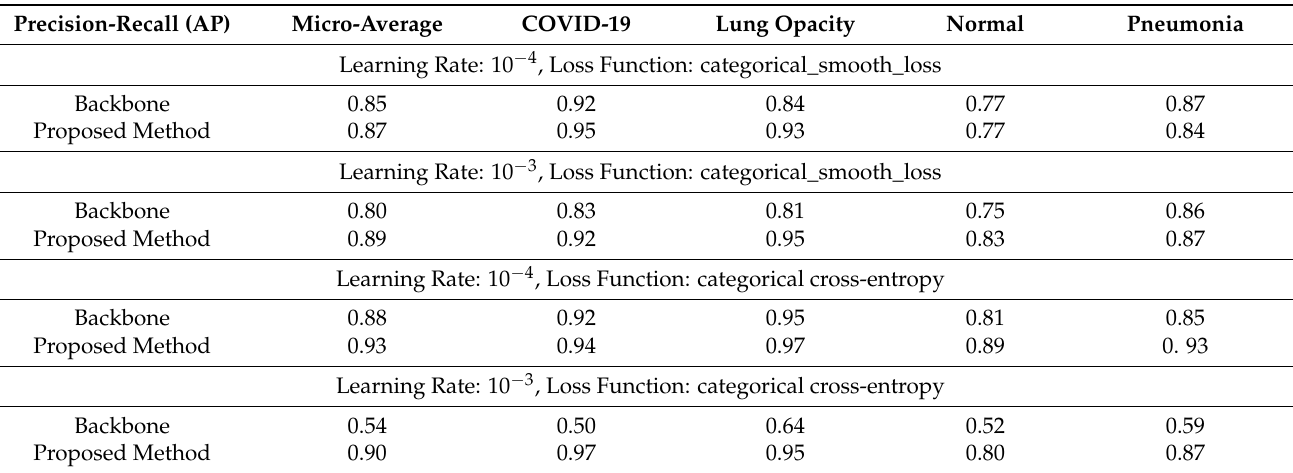
Table 9. Classification results of the backbone vs. proposed model based on PR curve using